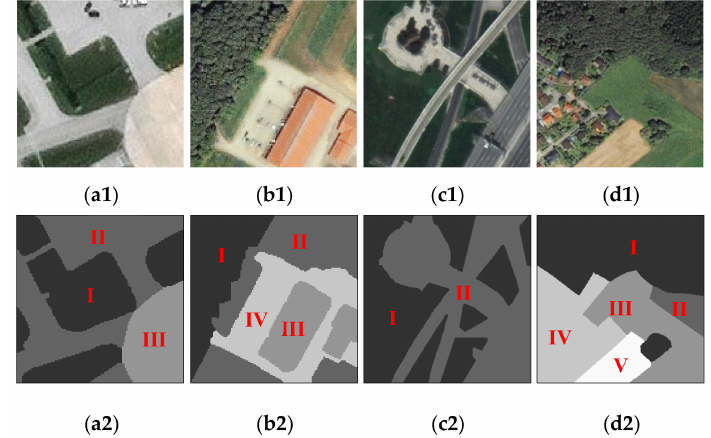
Figure 9. Multispectral remote sensing images. ( a1 – d1 ) Images 1–4; ( a2 – d2 ) The corresponding